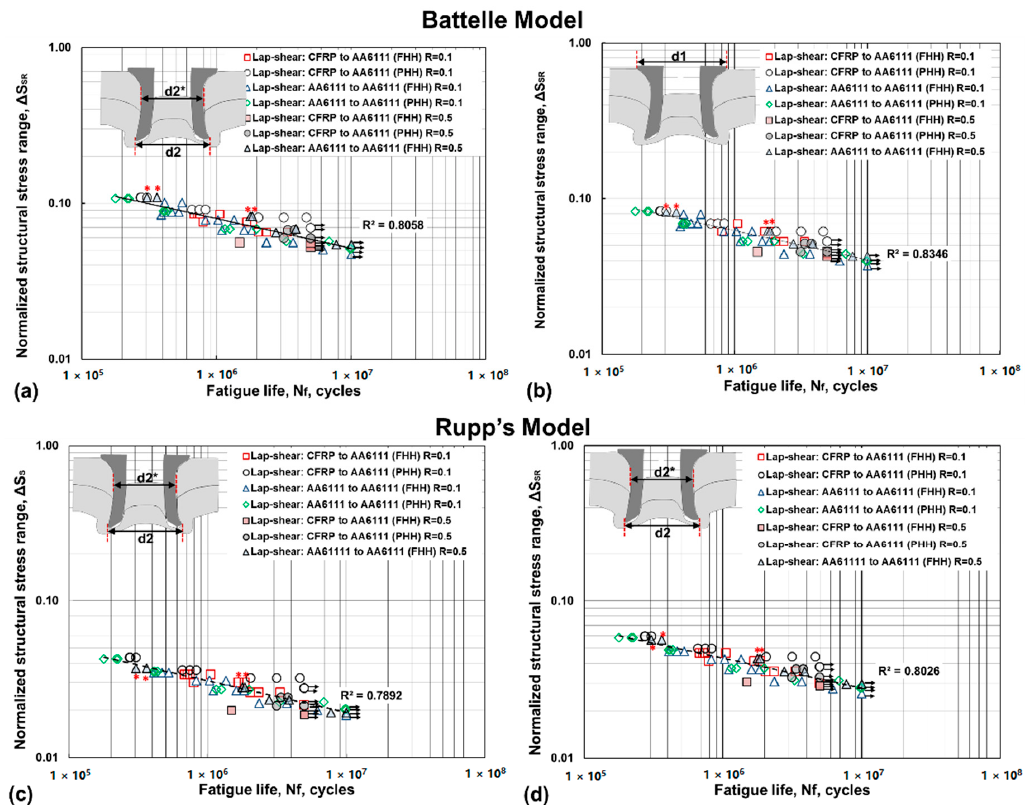
Figure 5. Master S-N curve obtained using the simplified Battelle structural stress concept ( a ) using flared rivet diameter d2 and d2* and ( b ) using the rivet head diameter d1 ; ( c ) master S-N curve obtained with Rupp’s model using flared rivet diameter d2 and d2 * and not considering the load ratio and ( d ) master S-N curve obtained with Rupp’s model using flared rivet diameter d2 and d2 * and considering the load